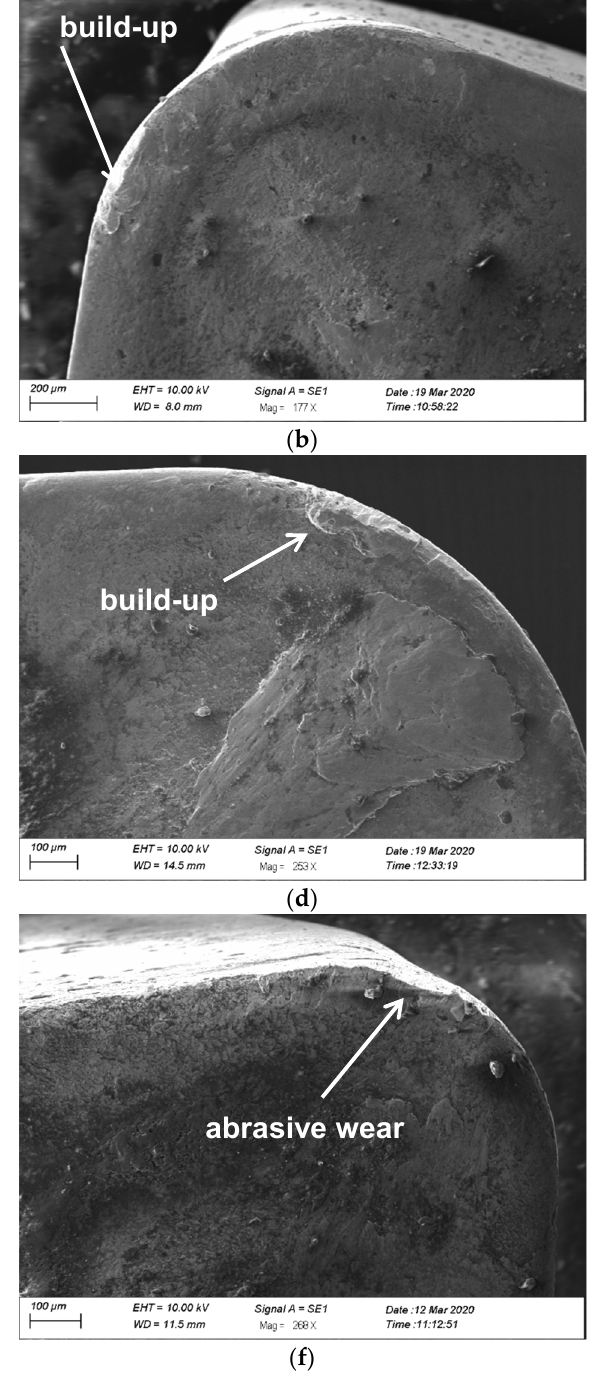
Figure 7. The view of the scanning electron microscopic: ( a ) flank wear for CC1 cutting insert and ( b ) rake face wear for CC1 cutting insert; ( c ) flank wear for CC2 cutting insert and ( d ) rake face wear for CC2 cutting insert; ( e ) flank wear for CC3 cutting insert and ( f ) rake face wear for CC3 cutting insert.